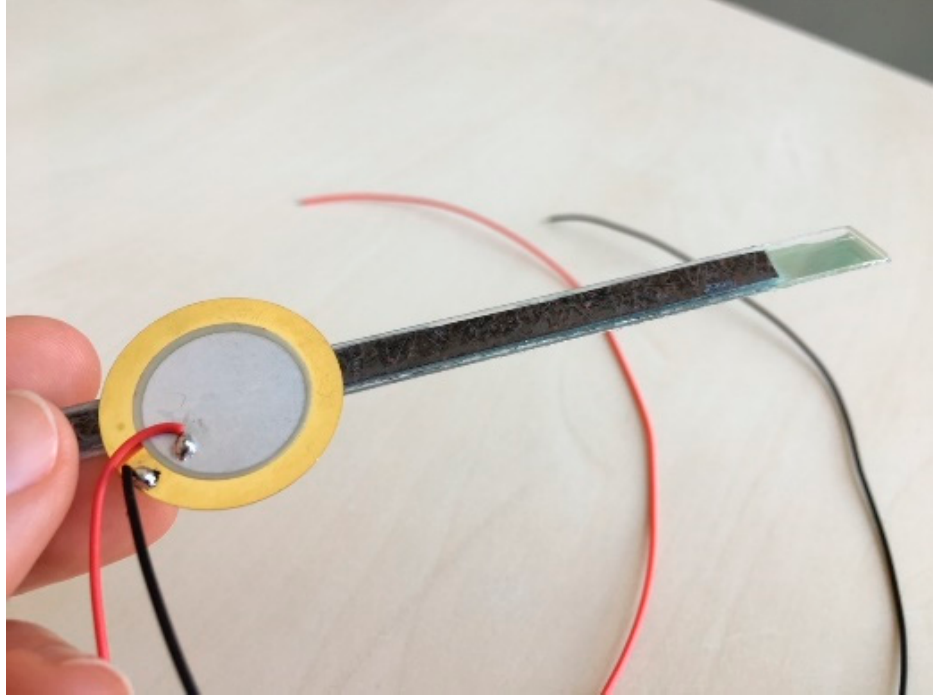
Figure 5. A student-built ME sensor model made out of a strip cut from a CD, a piezo-electric element, and thin steel.